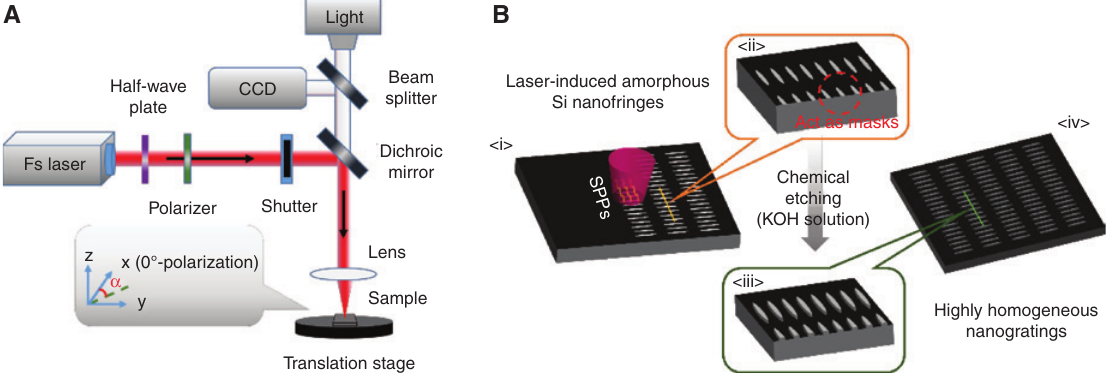
Figure 1: Schematic diagram of the experimental process. (A) Schematic of the setup for femtosecond laser fabrication. (B) Flow chart of the chemical wet-etching assisted femtosecond laser modification